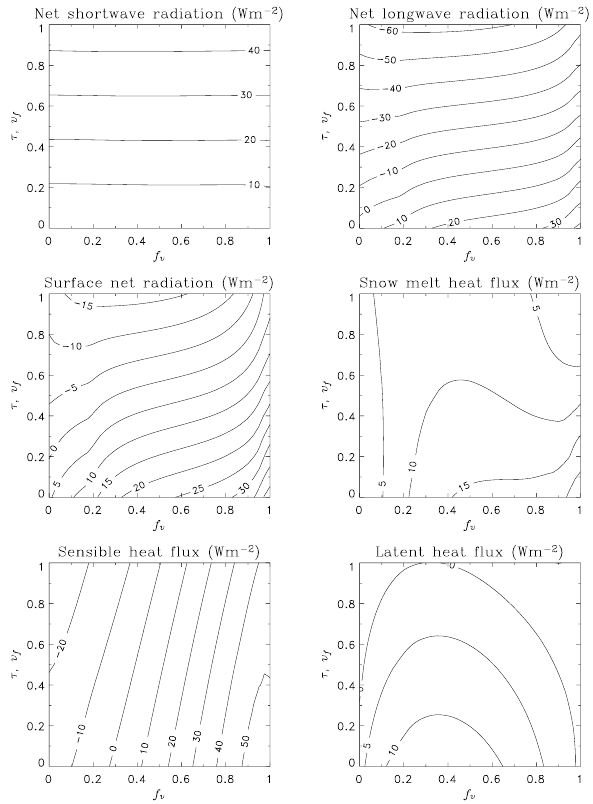
Fig. 10. Contour plots of average net shortwave, longwave and total radiation at the surface, and melt, sensible and latent heat fluxes for varying vegetation fraction f v , sky view factor v f and transmittance τ , assuming τ = v f